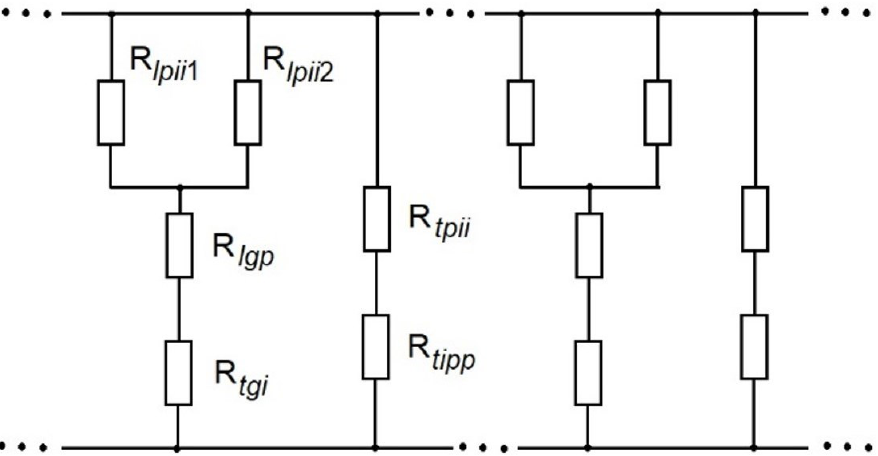
Figure 7. Equivalent circuit for one layer of PPLP insulation (the notations are for one cell of the equivalent